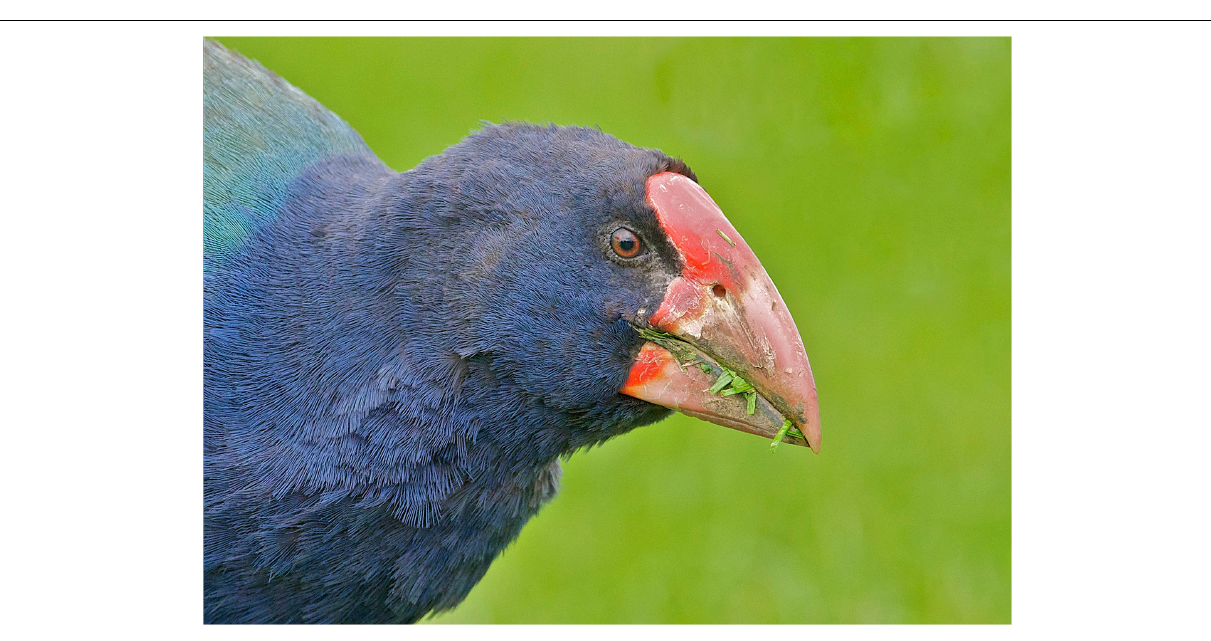
FIGURE 6 | Closeup of the head of the extant New Zealand Takahe ( Porphyrio mantelli ). The general proportions of the bill are comparable to those of the vastly larger-bodied extinct neornithine clade Gastornithidae. Photo by